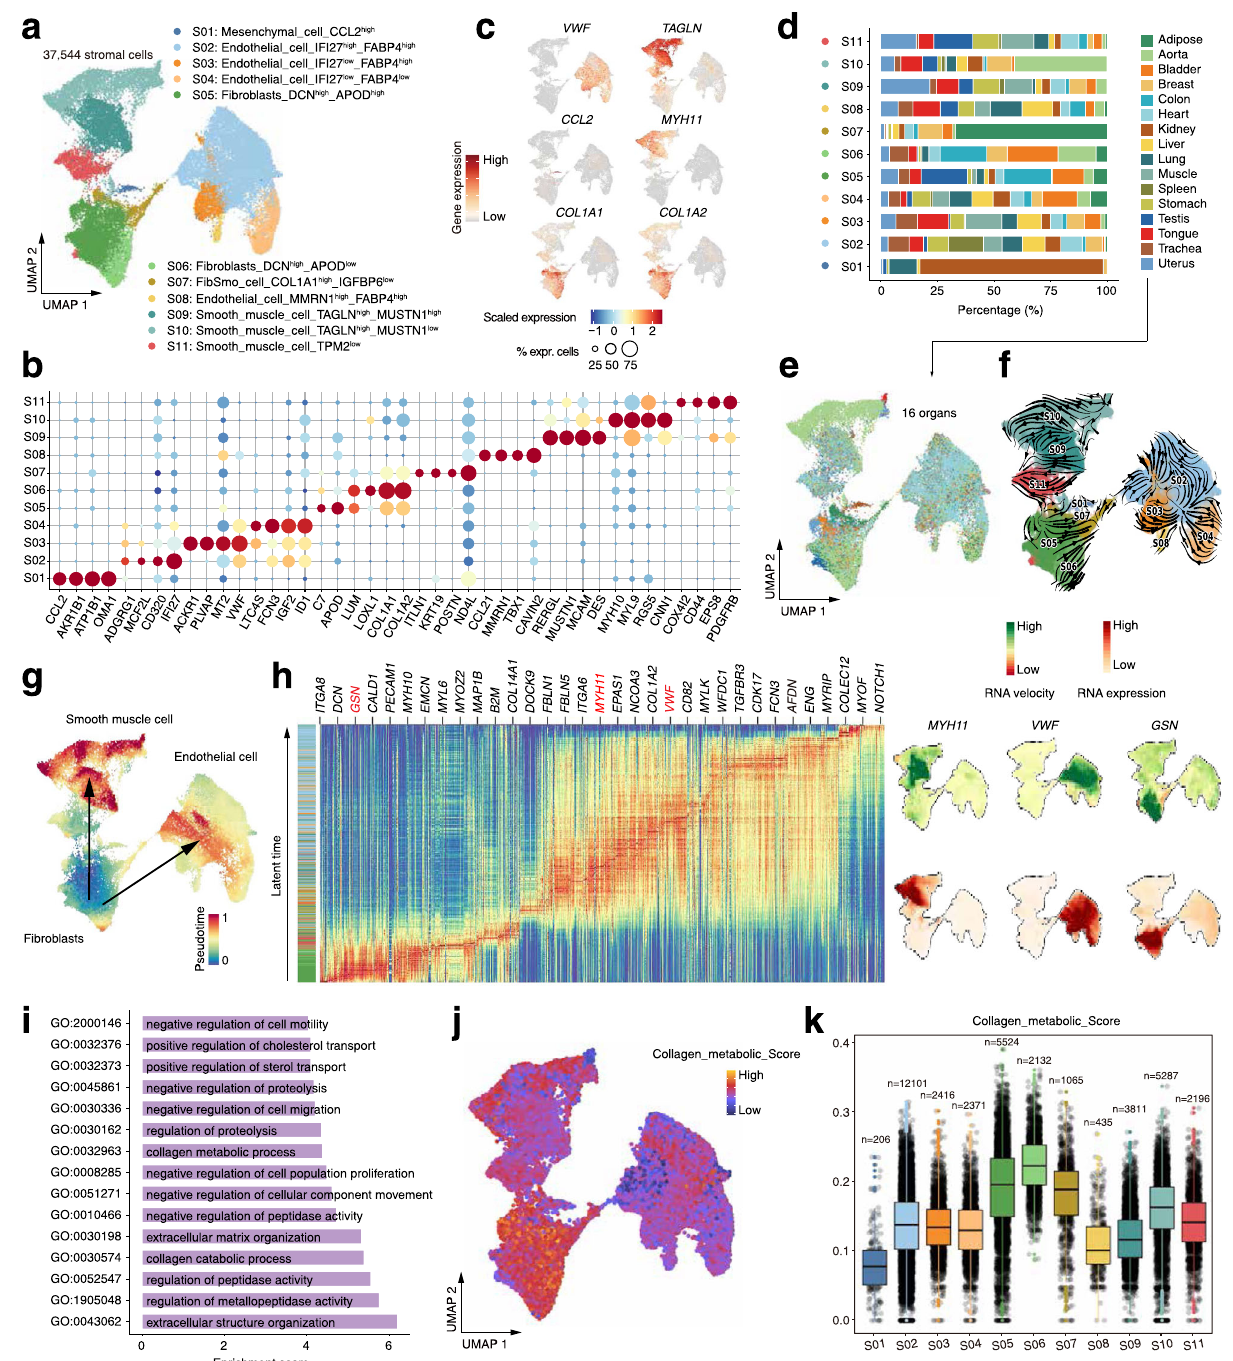
Fig. 3 Heterogeneity of stromal cells in different organs. a Distribution of eleven stromal cell subtypes on the UMAP. b Dot plots showing representative marker genes across the stromal subtypes. Dot size is proportional to the fraction of cells expressing speci fi c genes. Color intensity corresponds to the relative expression of speci fi c genes. c Feature plot showing the expression of selected marker genes. d Bar plot showing the percentage of cell subtypes in each organ. e Distribution of stromal cells from different organs on the UMAP. f Unsupervised pseudotime trajectory of the subtypes (S01-S11) of stromal cells by RNA velocity analysis. Trajectory is colored by cell subtypes. The arrow indicates the direction of cell pseudo-temporal differentiation. g UMAPs showing the pseudotime differentiation trajectories of fi broblasts, smooth muscle cells and endothelial cells respectively. h Heatmap showing the scaled expression levels of cell-type-speci fi c marker genes along the pseudotime differentiation trajectory. Examples of marker expression are shown in the right UMAPs. i Barplot showing the enrichment of functional pathways in fi broblasts (cluster S06). j , k UMAP plot and Box plot showing the distribution of gene signature scores estimated by UCell based on annotated genes ( n = 24) from the collagen metabolic pathway. The boxes indicate the 25% quantile, median (horizontal line), 75% quantile and Tukey-style whiskers (beyond the